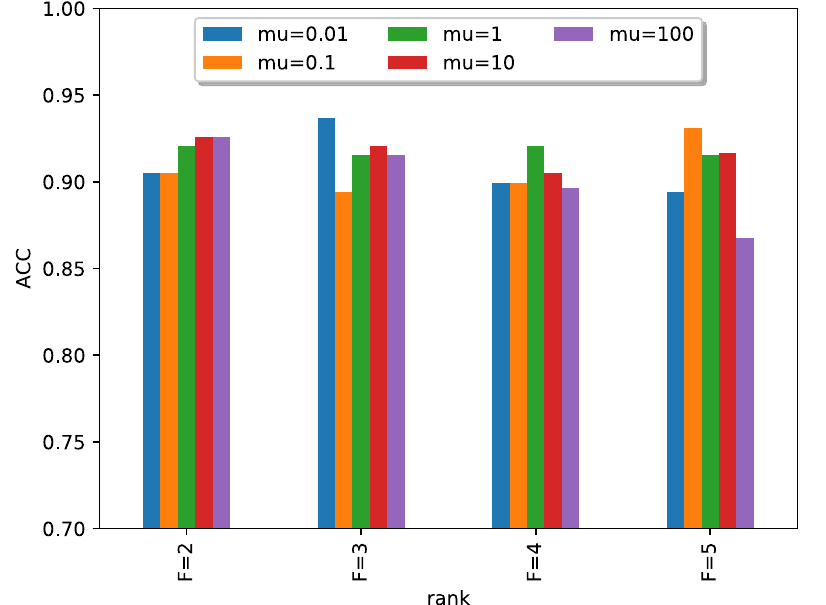
Figure 2. Choosing F and µ for the tensor completion algorithm.